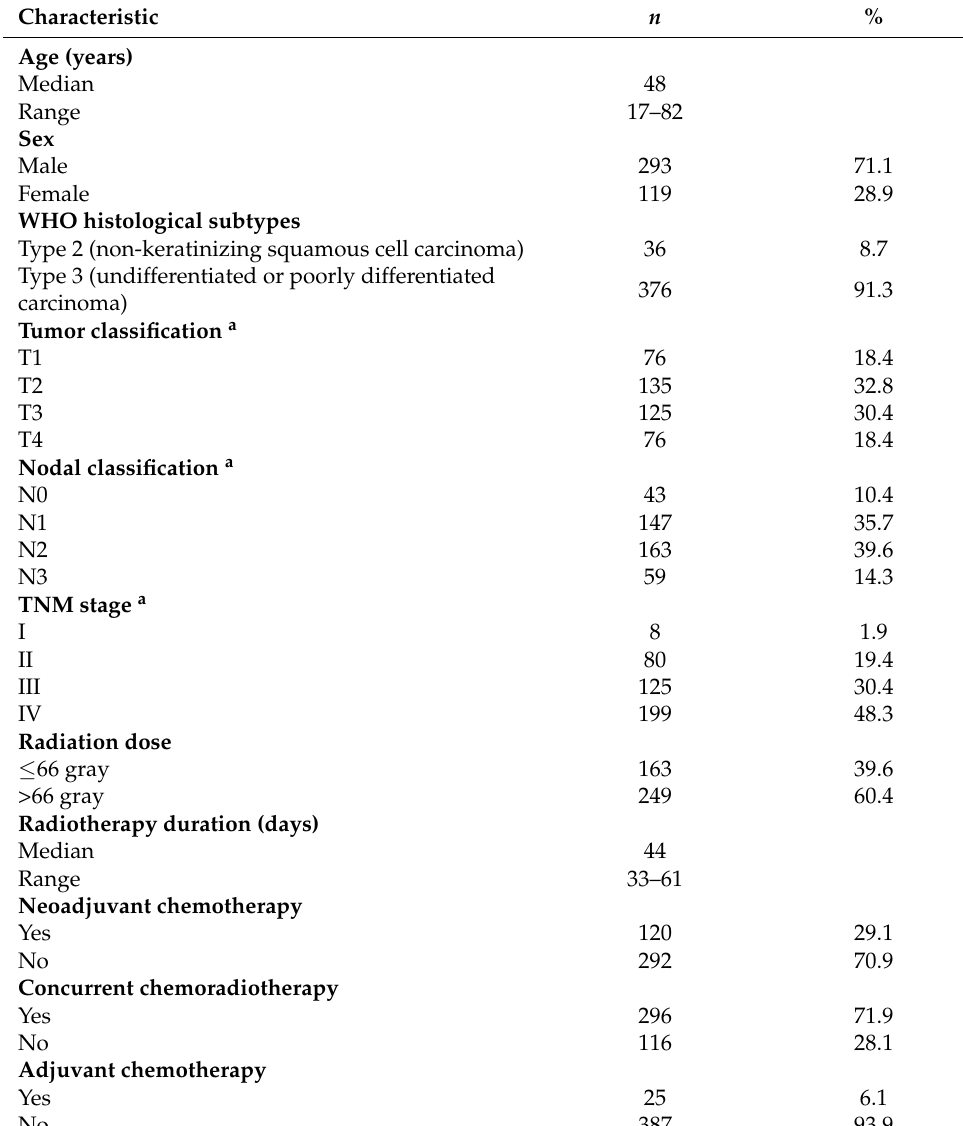
Table 1. Characteristics of all patients in the dataset (N =